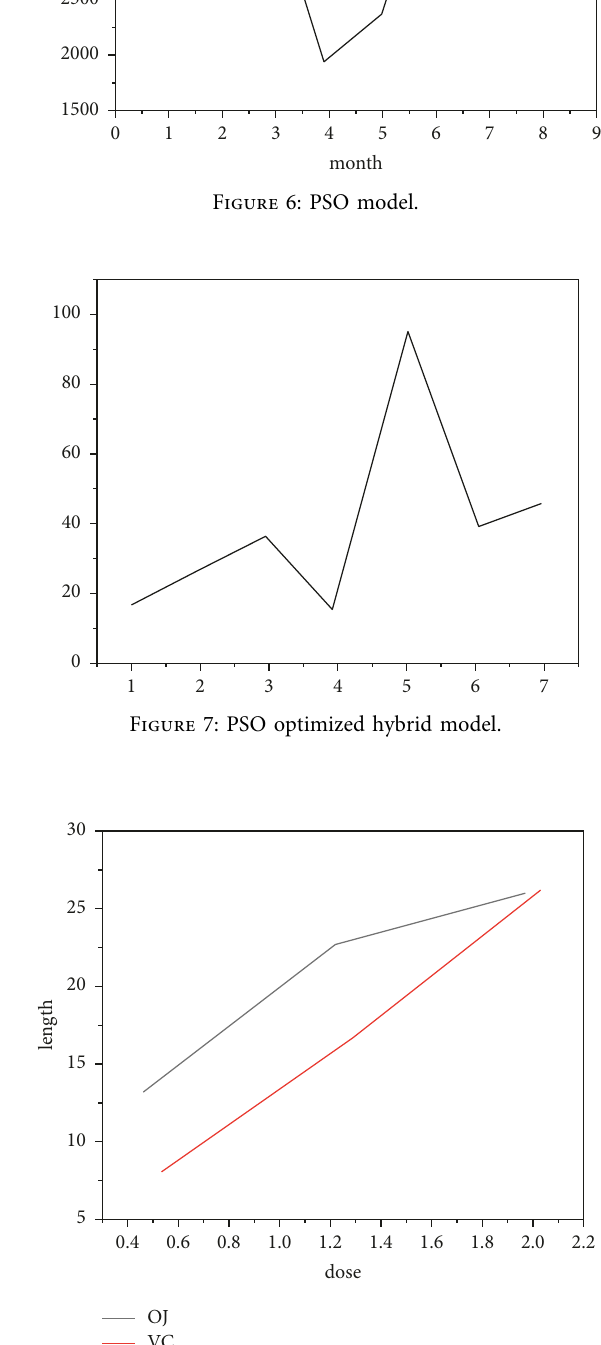
Figure 8: Single core RVM model prediction.